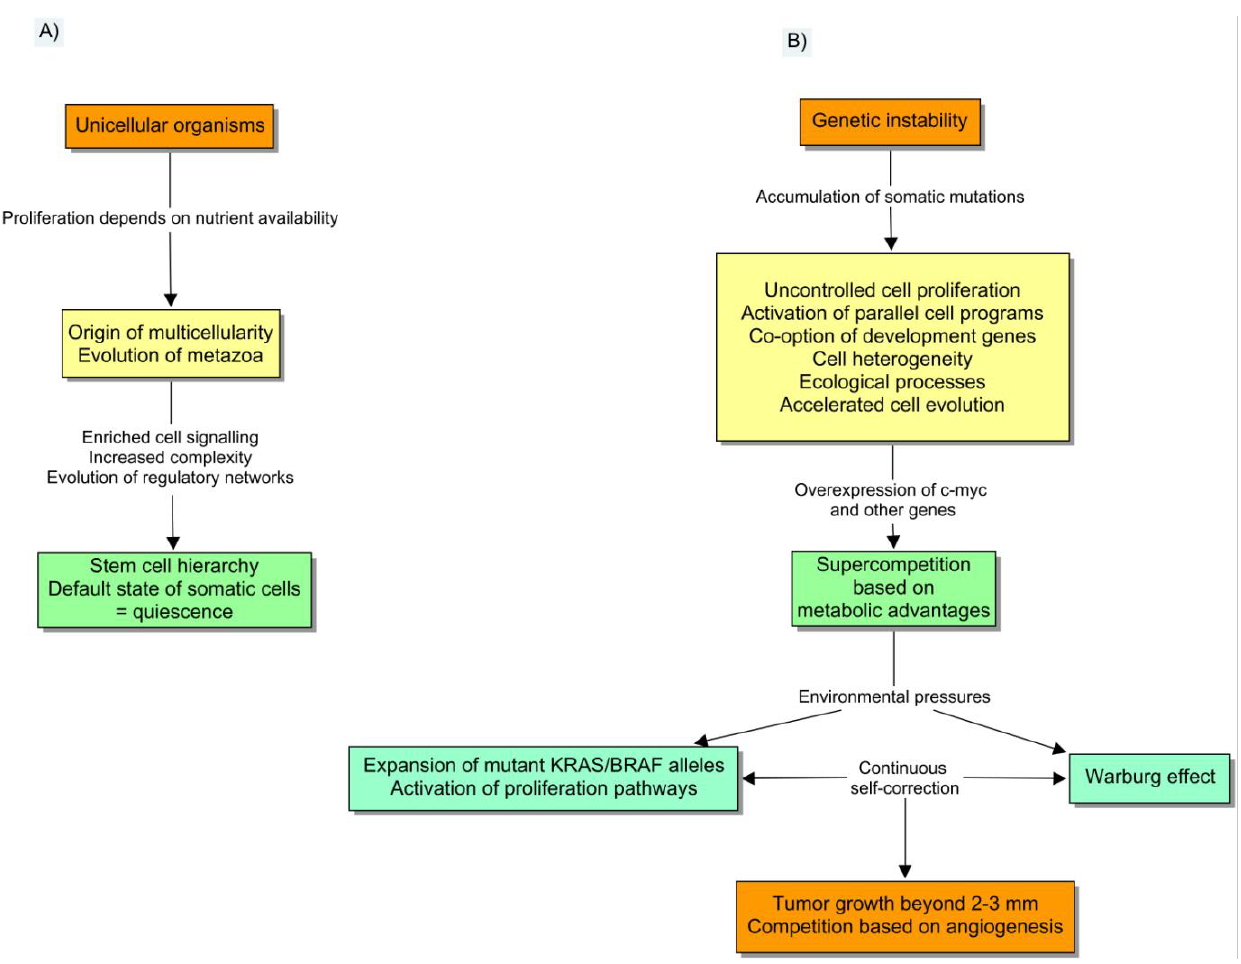
Figure 2. How to “construct and deconstruct” a multicellular organism. (a) The regulation of the asymmetric division of stem cells is an evolutionary trade-off between terminal differentiation and proliferation. The origin of multicellularity entailed large increases in signal transduction pathways, to guarantee and regulate these hierarchies. So, unregulated cell proliferation constitutes a pathological state. (b) Genetic instability is linked to the appearance of ecological interactions, and it makes tumorigenesis different from other processes such as embryological development, and other emergent phenomena of gene regulatory networks. Notice that the reverse process of “metazoan evolution” is